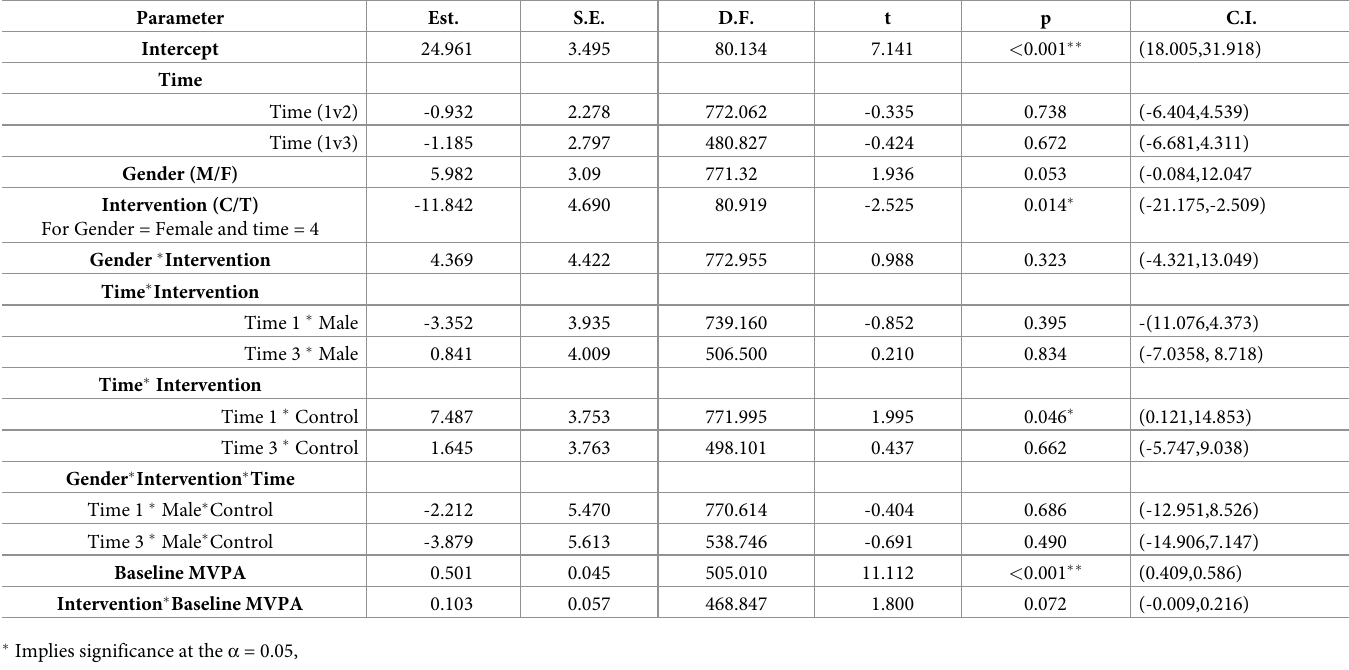
Table 3. Parameter estimates of main fixed effects.